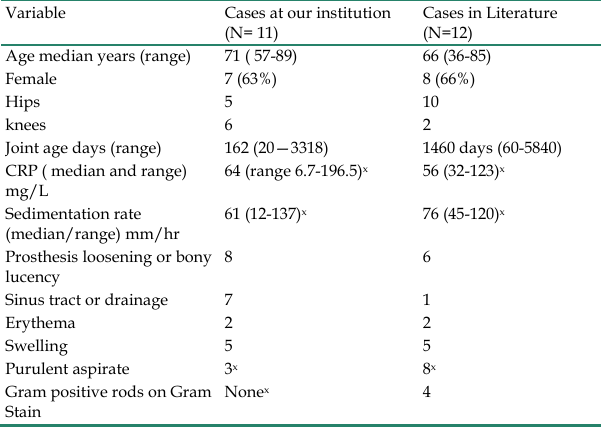
Table 1 : Demographic and clinical presentation between the two groups